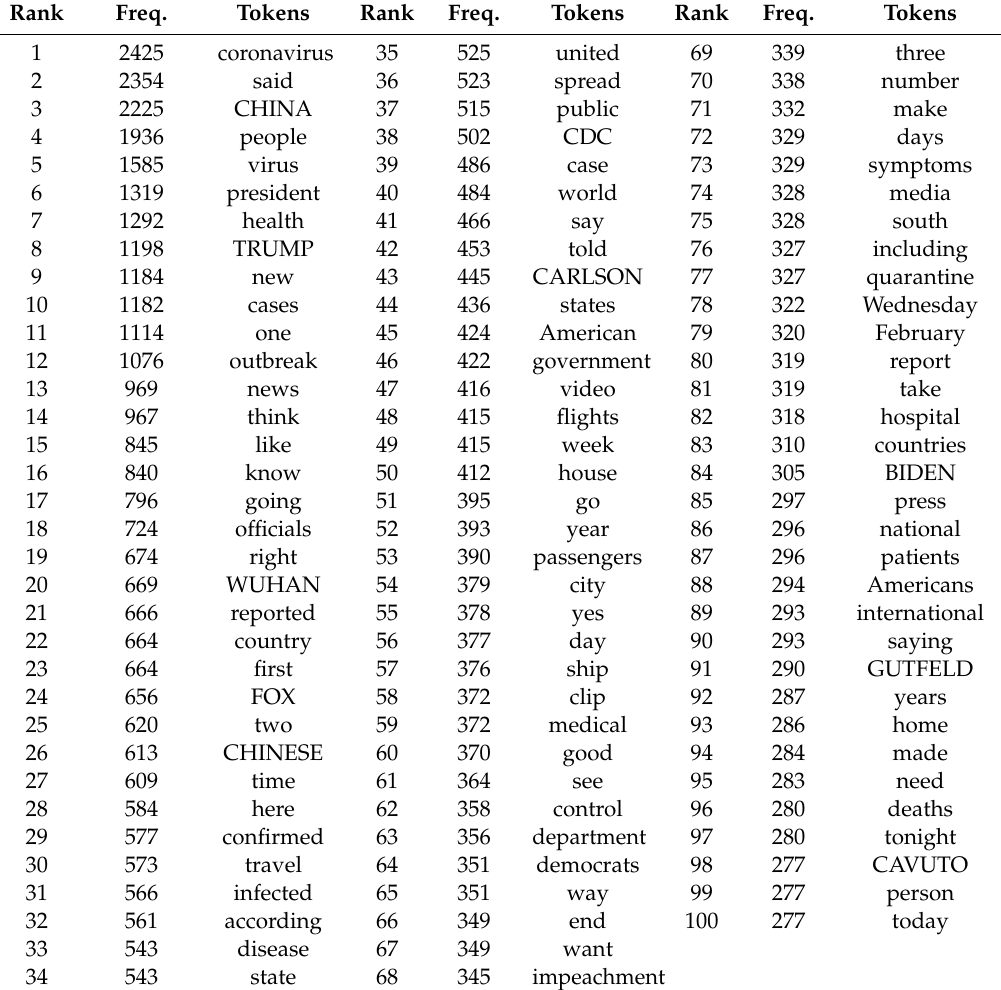
Table 5. An example of the refined word list from the input corpora (partial